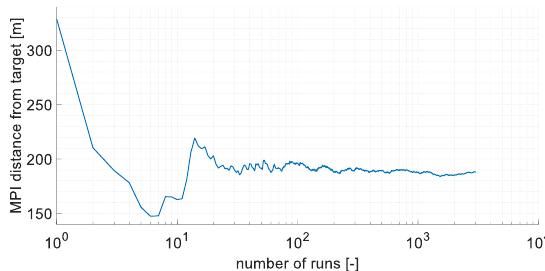
Figure 13 . The mean impact point location as a function of the number of runs. Figure 13. The mean impact point location as a function of the number of